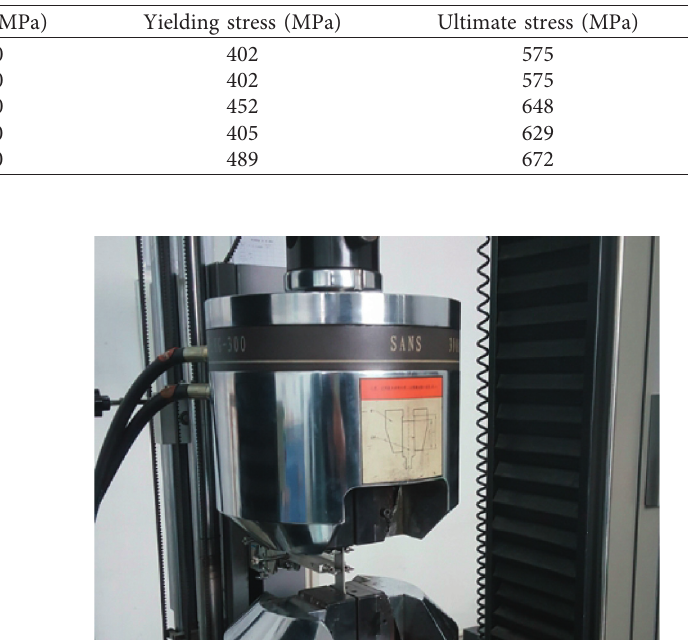
Table 3: Properties of reinforcing